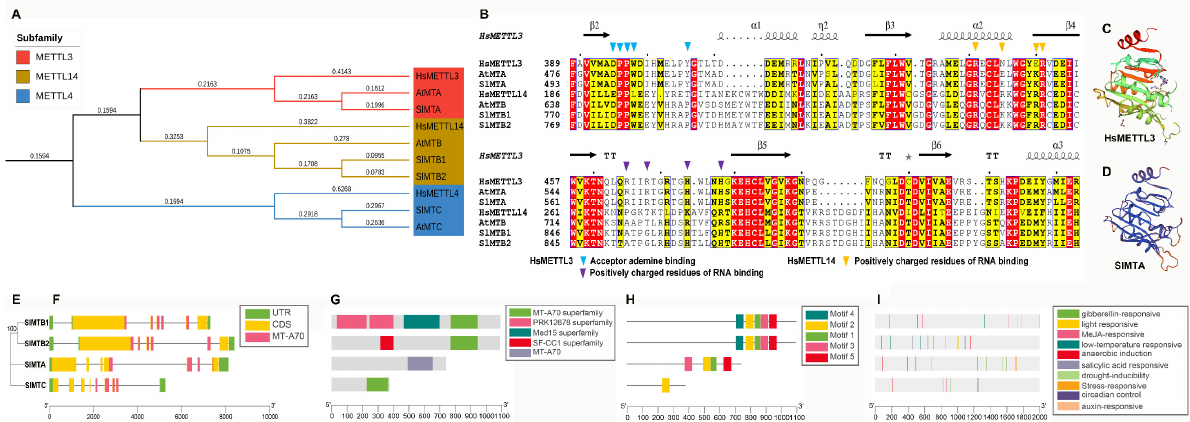
Figure 2. Evolutionary and structure analyses of the MT-A70 family in tomato. ( A ) Phylogenetic tree of MT-A70 family proteins from tomato, Arabidopsis , and human. ( B ) Sequence alignment of METTL3 and METTL14 subfamily proteins from tomato, Arabidopsis , and human. The secondary structural elements in the HsMETTL3 (PDB: 5l6d) MT-A70 domain are shown above. The colored triangles indicate key functional residues in human. ( C , D ) Three-dimensional structures of HsMETTL3 and SlMTA. ( E ) Phylogenetic tree of MT-A70 family proteins in tomato. ( F ) Gene structure analysis. The coding sequence (CDS), untranslated region (UTR), and MT-A70 domain are displayed in different colors, and the lines between boxes represent introns. ( G , H ) Conserved domain and motif analysis. ( I ) Locations of cis-elements in the 2 kb promoter sequences.